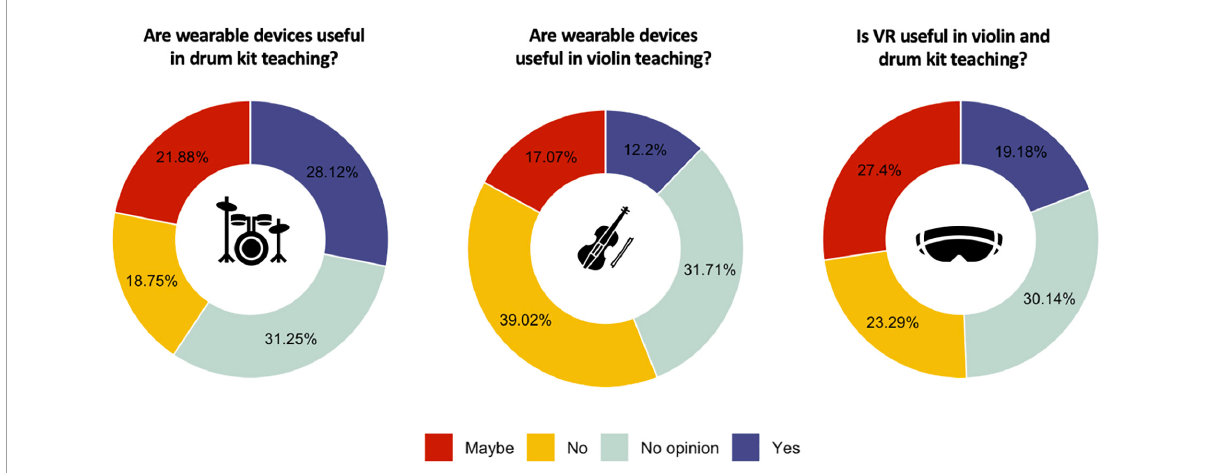
FIGURE1 Teachers’ opinions about usefulness of wearable devices and VR applications in violin and drum kit